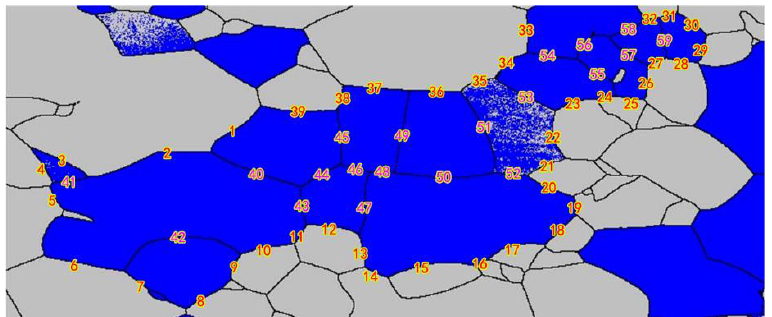
Figure 6. Some grains extracted from EBSD data in Figure 5.